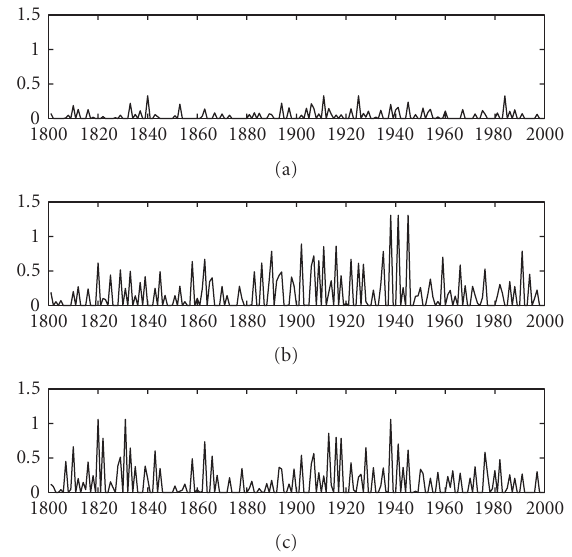
Figure 2: Fault isolation residuals. The time unit is the minute. Top: residual rejecting the fault of actuator 1. Middle: residual rejecting the fault of actuator 2. Bottom: residual rejecting the fault of actua- tor